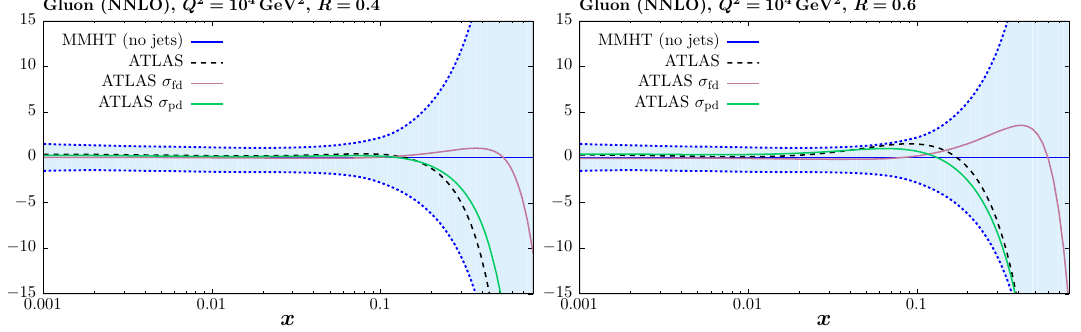
Fig. 5 The impact on the gluon PDF at NNLO of the ATLAS 7 TeV jet data [23], including two alternative treatments of the correlated sys- tematic errors described in the text. The percentage difference in com-